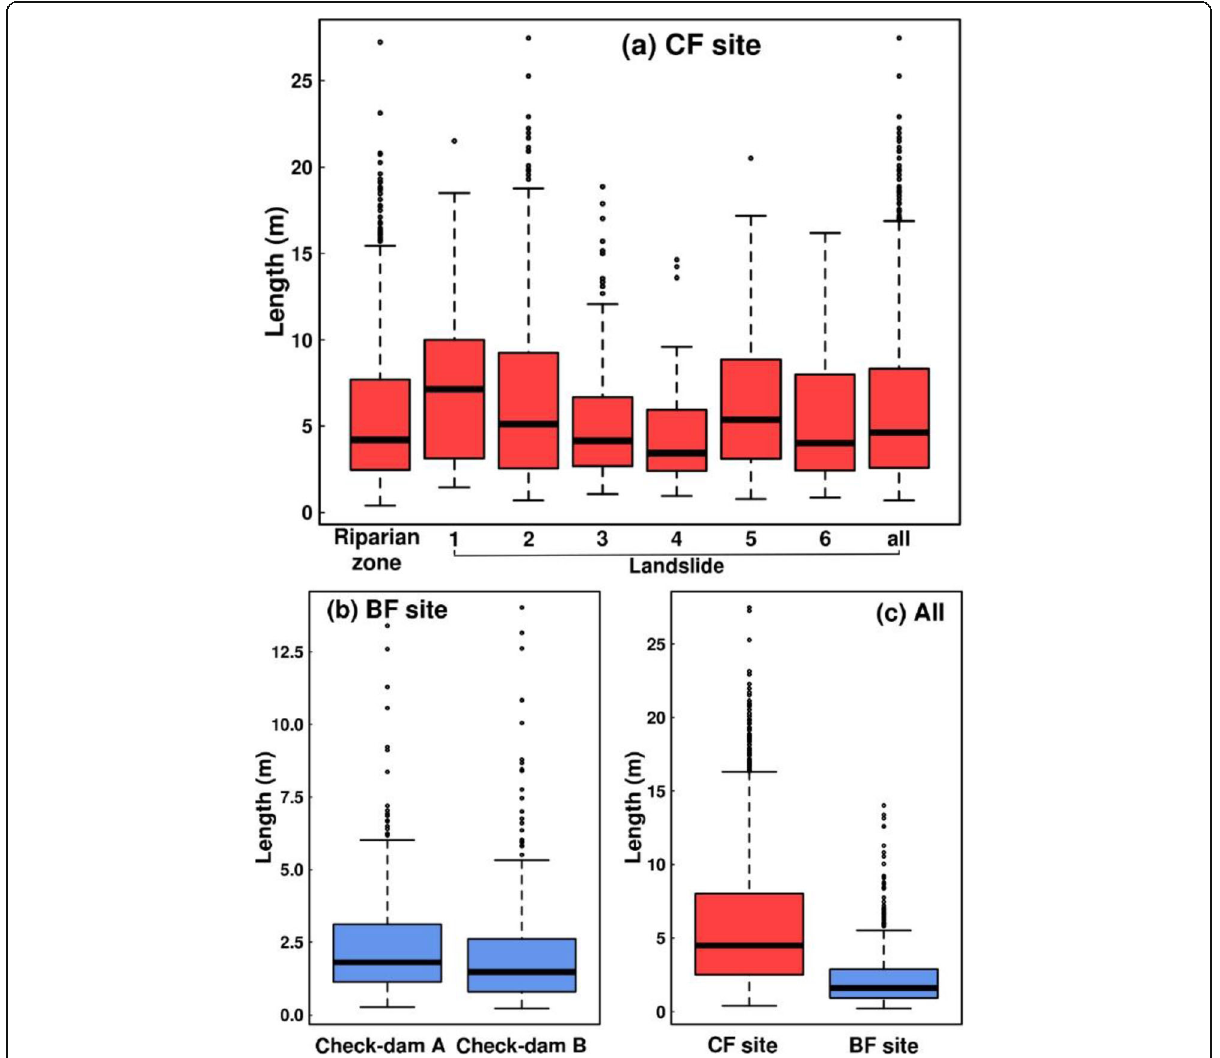
Fig. 8 Boxplots of the extracted lengths: a the coniferous forest (CF) site, b the broadleaf forest (BF) site, and c all measured lengths. In panel a , the labels of the landslides correspond to Fig. 2a ( “ All ” indicates the total number of landslides). The wood piece extracted in the area excluding landslide scars was regarded as the riparian zone (Fig.